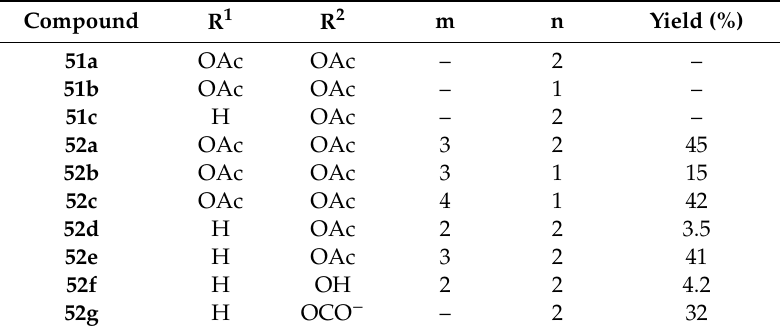
Table 2. Yields of functionalized cyclocholates 52a–e (m = ring size).